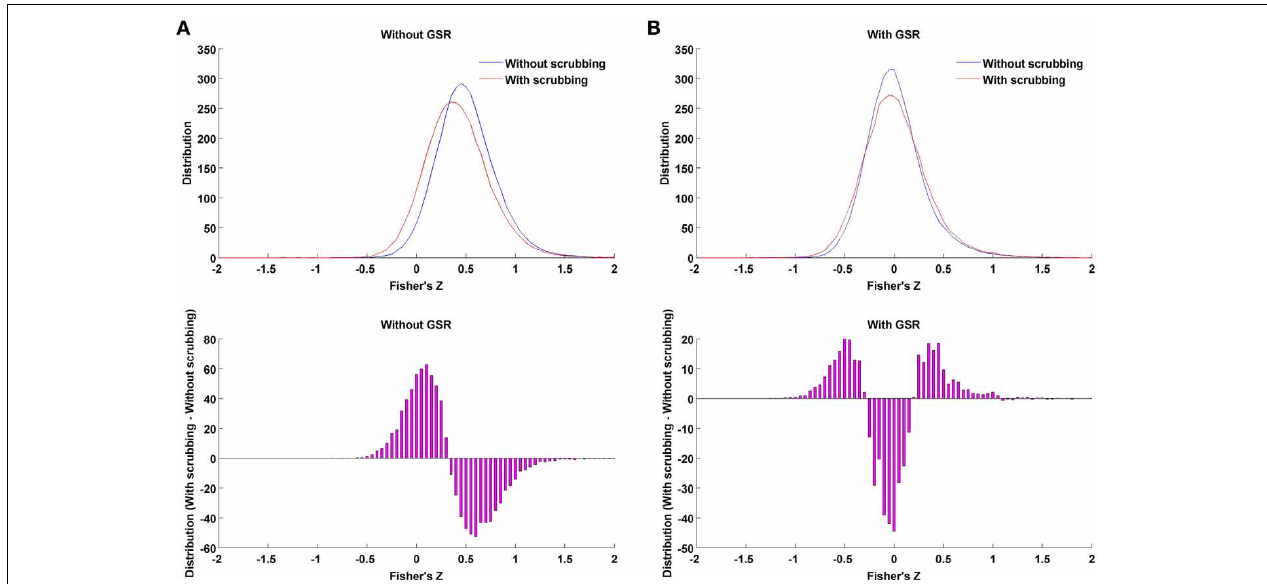
FIGURE 11 | Impact of scrubbing on correlation distribution. Twenty-five subjects with highest motion (to allow a number of time points being scrubbed) of the 158 subjects were selected to form the mean distribution in the case of without GSR (A) or with GSR (B) . Top: the distribution of Fisher’s Z across region pairs were averaged across the 25 subjects for either without scrubbing (blue) or with scrubbing